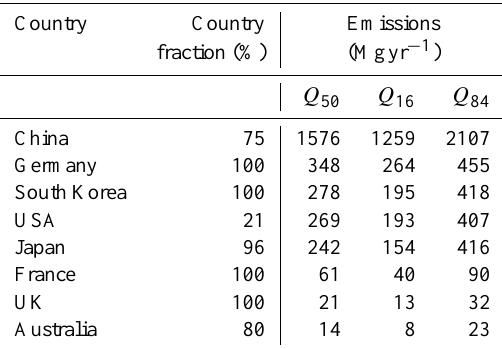
Table 1. National SF 6 emissions for 2012 derived using the hierar- chical Bayesian method for the regions surrounding four AGAGE stations. The fraction of the country for which emissions are derived (i.e., fraction of EDGAR emissions contained within the domains shown in Fig. 2) is tabulated along with 50th (median), 16th and 84th percentiles of the posterior emissions PDF.